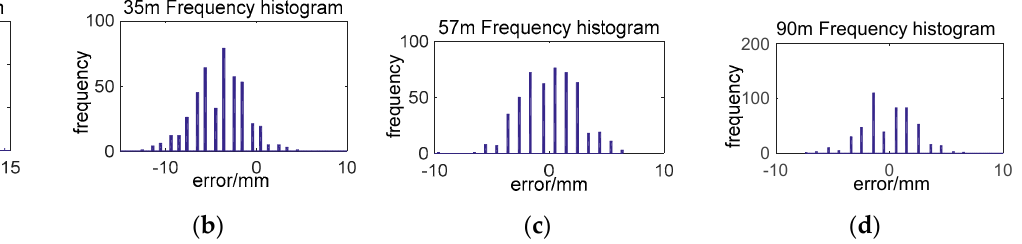
Figure 9. Error frequency histogram of the ranges within different distance scales. ( a ) The error frequency histogram of the ranges within 20 m; ( b ) The error frequency histogram of the ranges within 35 m; ( c ) The error frequency histogram of the ranges within 57 m; ( d ) The error frequency histogram of the ranges within 90 m.